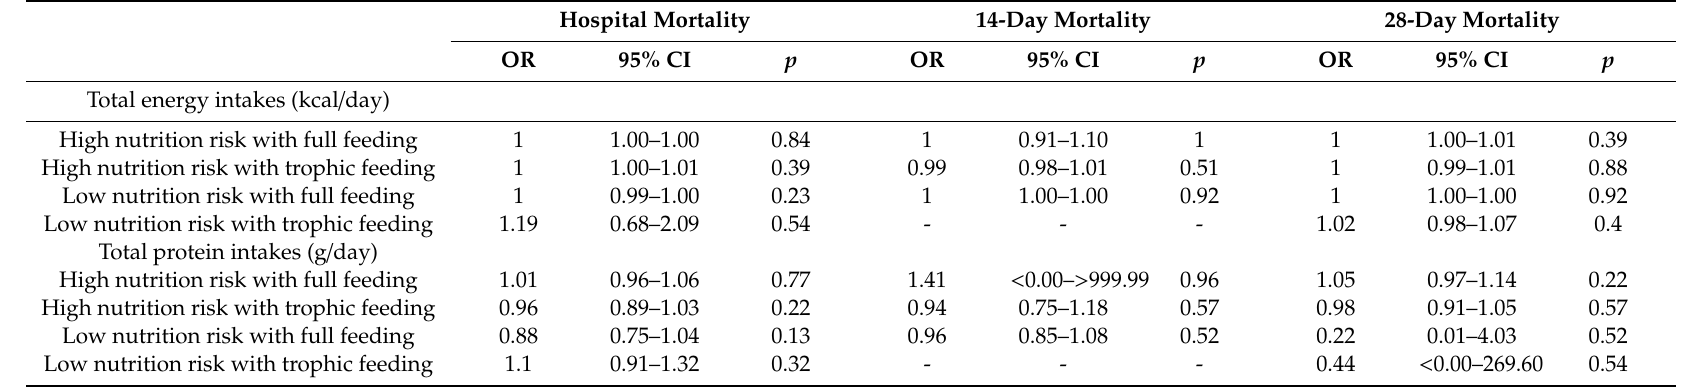
Table 2. Adjusted odds ratios of hospital mortality, 14-day mortality, and 28-day mortality in high and low nutrition risk critically ill patients treated with full or trophic feeding 1 .